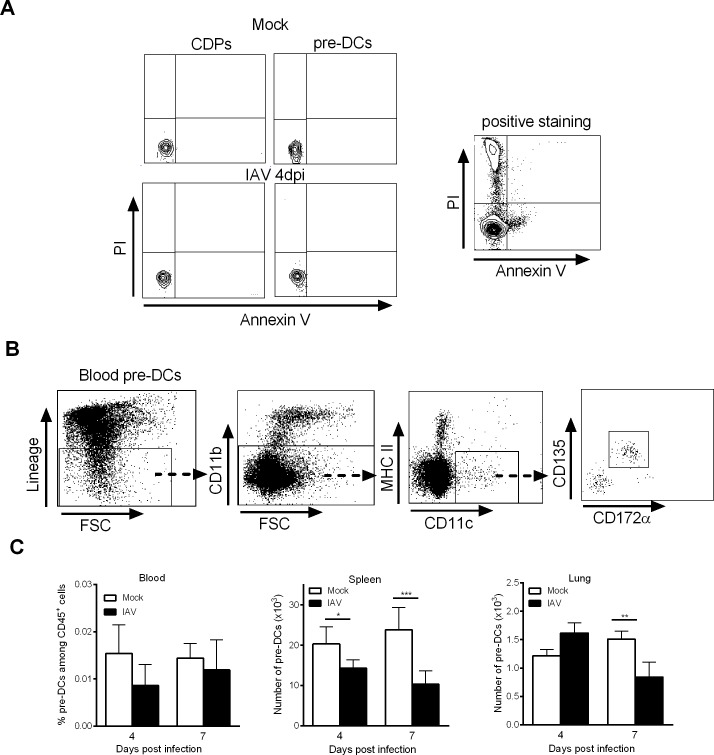
Influenza A virus infection does not lead to DC progenitor apoptosis or egress.(A) Representative dot plots of BM CDPs and pre-DCs from mock-treated and IAV-infected mice (4dpi) labelled with annexin V and iodide propidium are shown (left panels). Bone marrow cells left several hours at 37°C in PBS are positively stained for Annexin V and iodide propidium (positive staining, right panel). (B, C) Mice were infected i.n. with H3N2 virus and pre-DCs were quantified in peripheral tissues. (B) Example of gating strategy for blood pre-DC analysis. (C) The frequency of blood pre-DCs (left) and absolute number of spleen and lung pre-DCs (middle and right) were assessed by flow cytometry at 4dpi and 7dpi. Means ± SEM of 6–12 mice are represented. *, p < 0.05; **, p < 0.01.